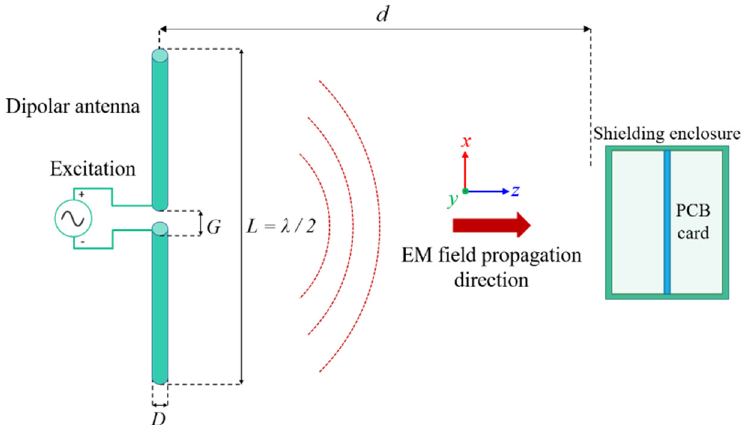
Figure 12. Schematic drawing of half-wave dipole antenna radiation.